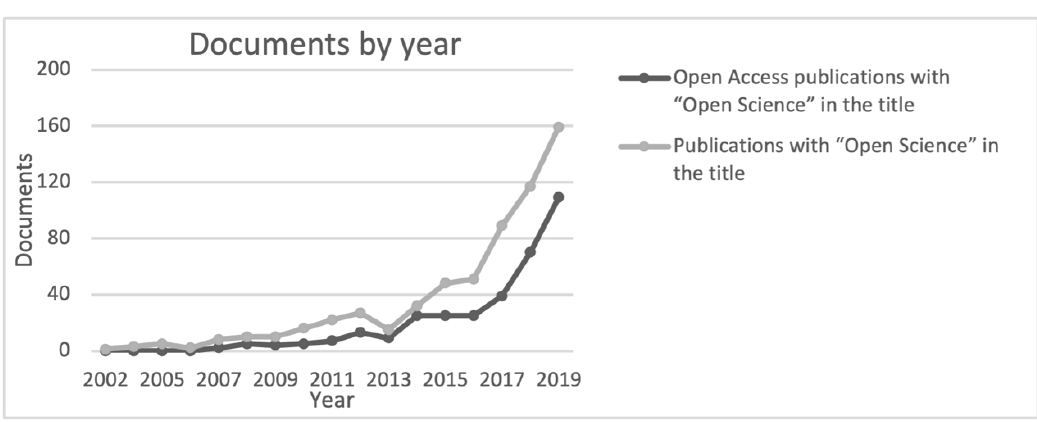
Fig. 3 Number of publications with “Open Science” in the title by year and publishing model (2002 -2019). Source: Authors’ elaboration on